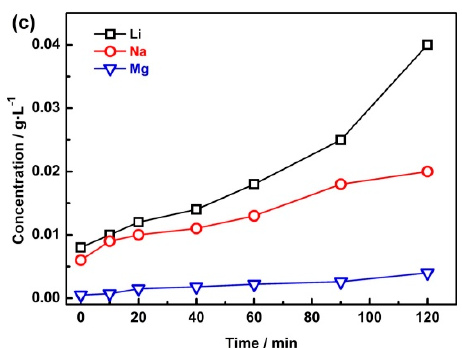
Figure 4. The main results in the RO process. ( a ) The relationship of the operation pressure and the flux of the membrane; (b ) concentration of Li + , Na + , K + , and Mg 2 + in the collected retentate; ( c ) concentration of Li + , Na + , K + , and Mg 2 + in the permeate flow.